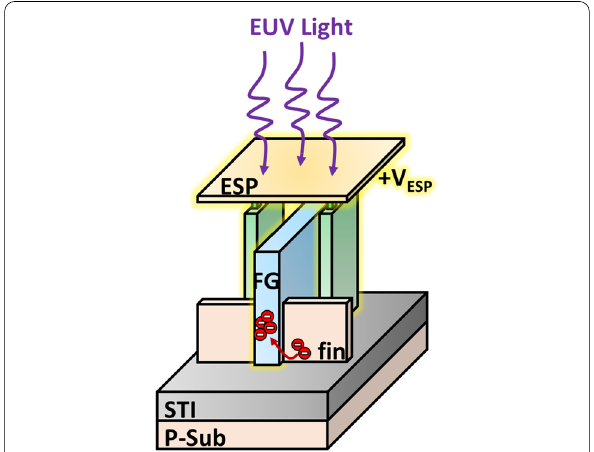
Fig. 1 Illustration of the sensing mechanism of the proposed EUV micro‑detector